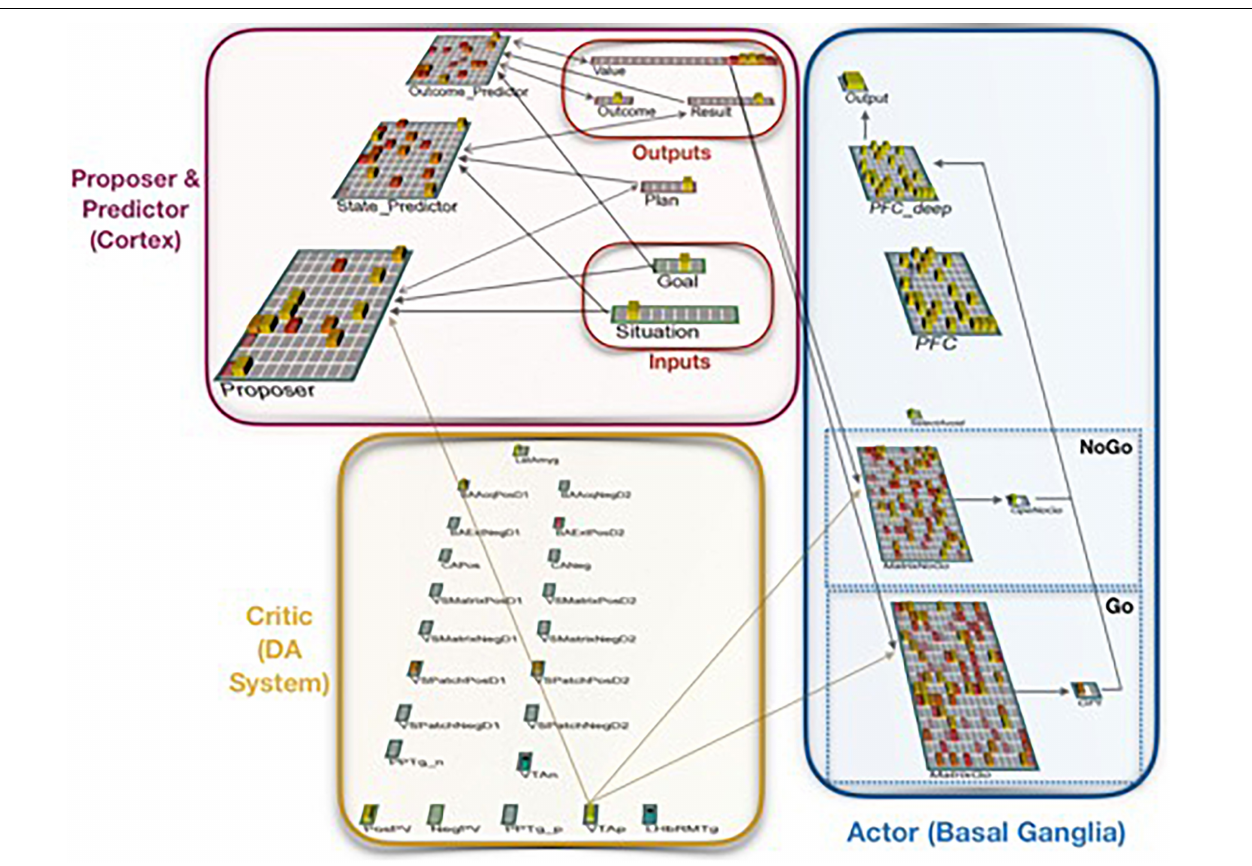
FIGURE 2 | Neural network implementation of the Proposer-Predictor-Actor-Critic theory. The model performs a three-factor task of choosing a Plan that accomplishes a current Goal in a current Situation. This abstract task can be conceptualized as navigation, social interaction, etc. The network’s Proposer component selects one Plan, based on pattern completion from inputs representing the current Situation and the current Goal. Each Plan deterministically produces an Outcome, each of which has one associated Result. The model is rewarded if that Result matches the current Goal. The Predictor component (when it is used) then predicts the resulting Outcome and Result (based on the proposed Plan and the current Situation), and the Actor component then uses that prediction as input to accept or reject that plan. If the plan is rejected, this computational cycle begins again with a new plan from the